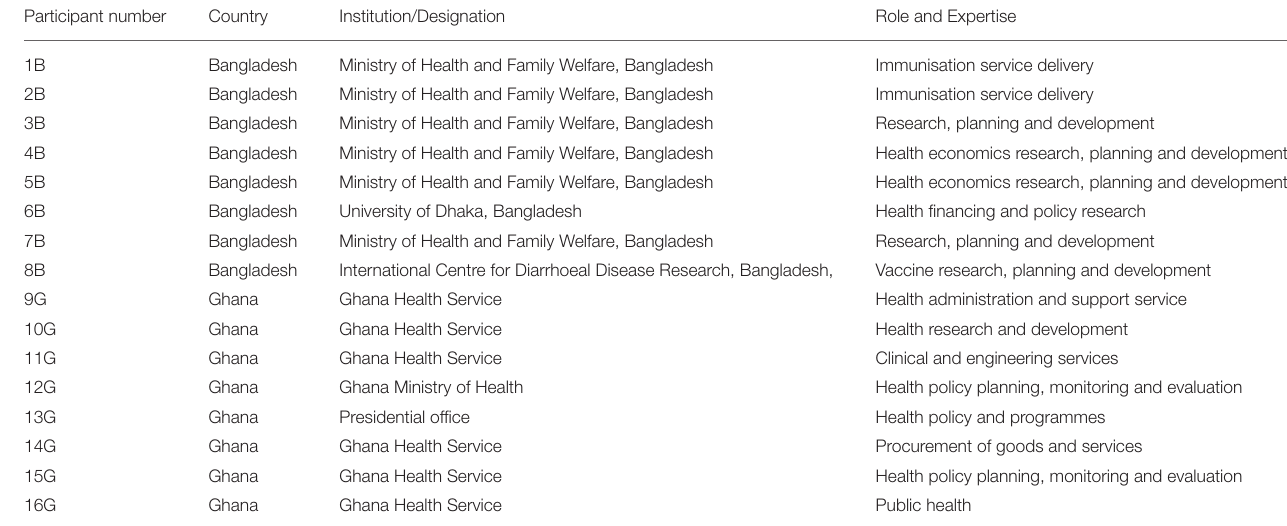
TABLE 1 | Characteristics of study participants. Participant